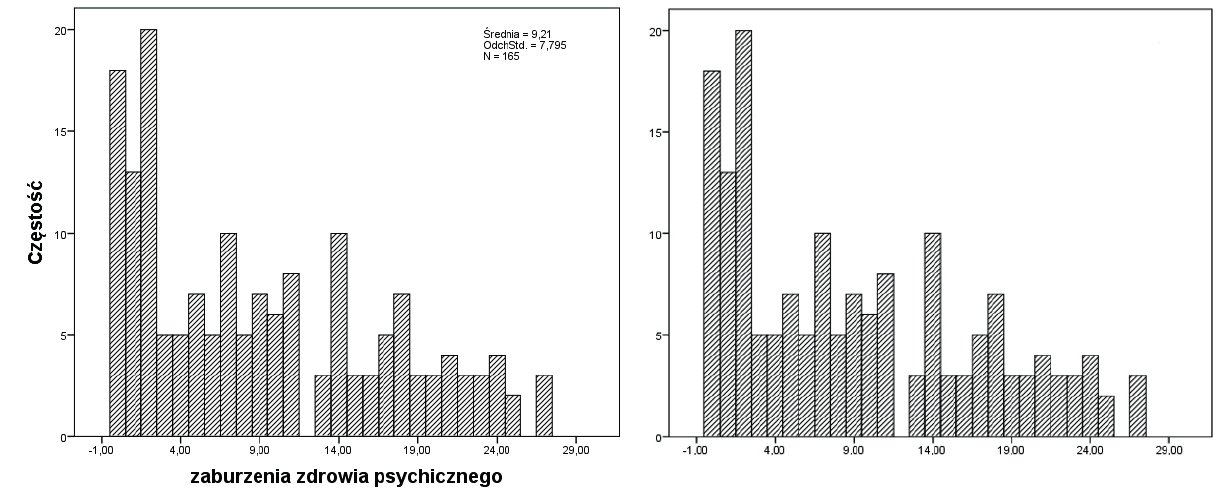
Figure 2. Summary of the results of the GHQ-30